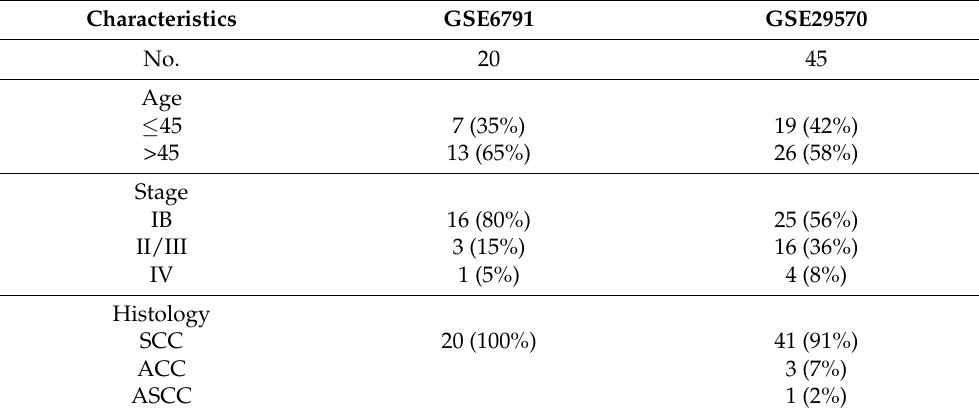
Table 1. Clinicopathological features of cervical cancer patients examined in this